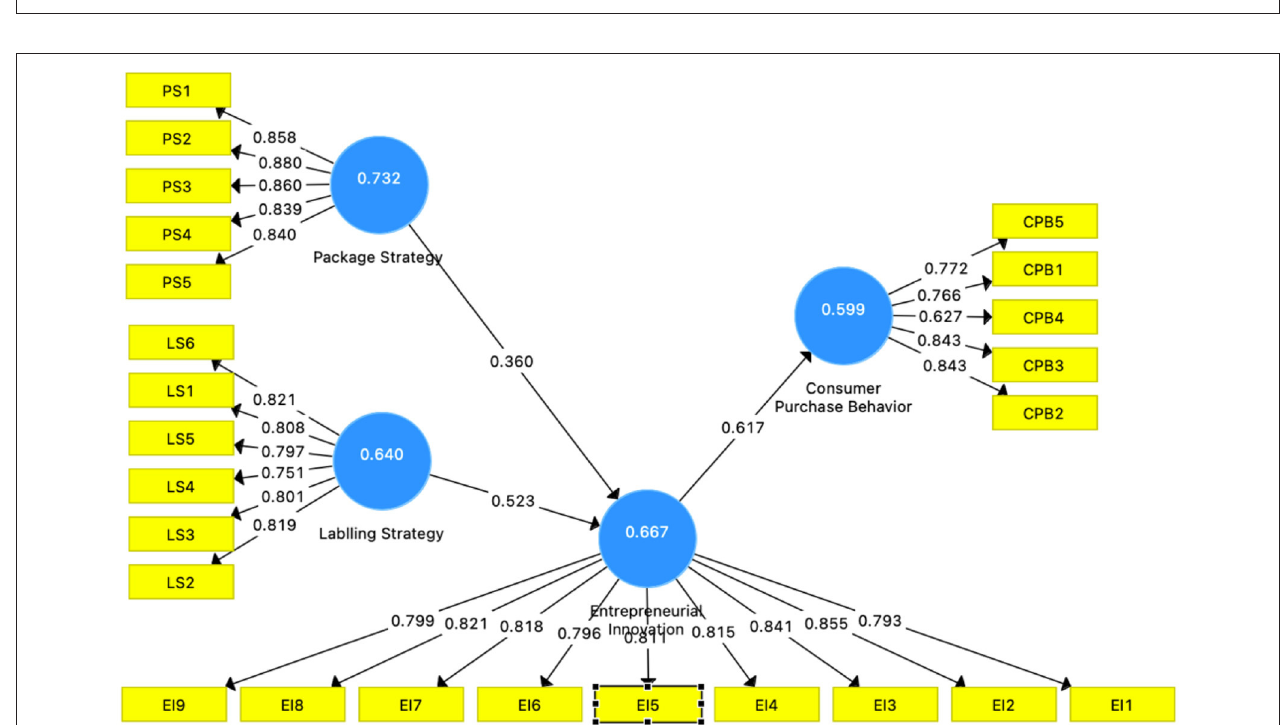
FIGURE 2 | Measurement